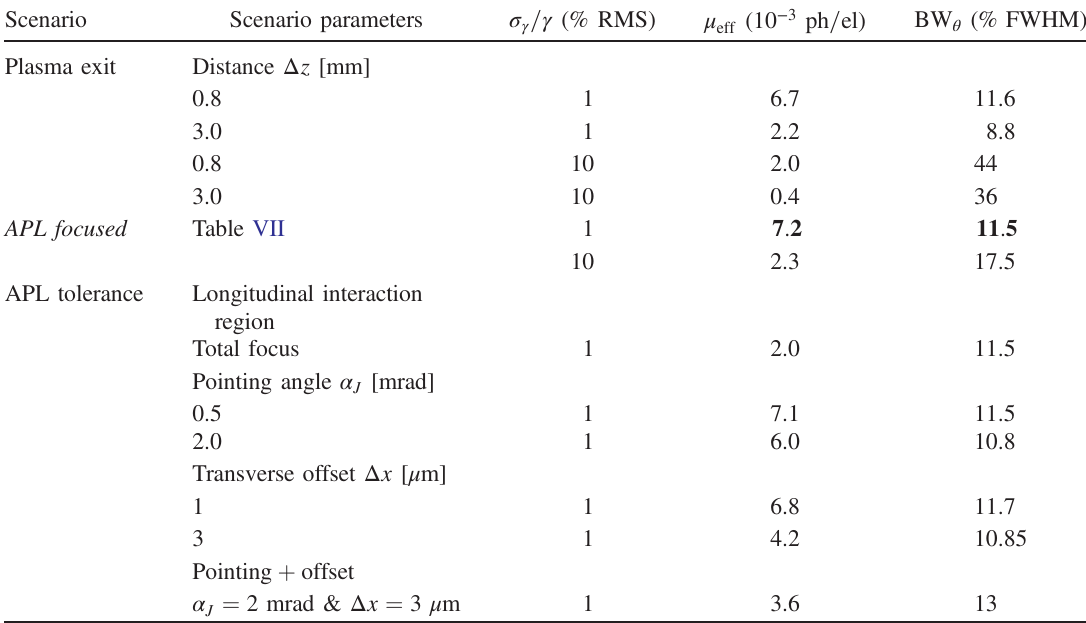
) and bandwidth (BW θ ) within the design divergence of (cid:2) 0 . 5 mrad eff